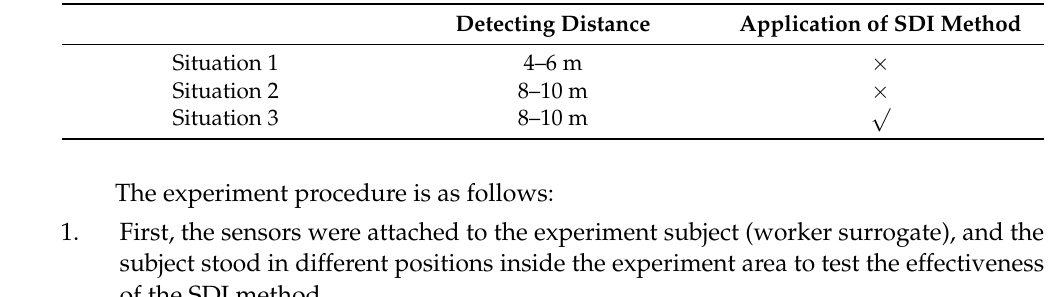
Figure 7. The experiment area layout (top view and 3D front view). Table 1. Description of simulation situations. Detecting Distance